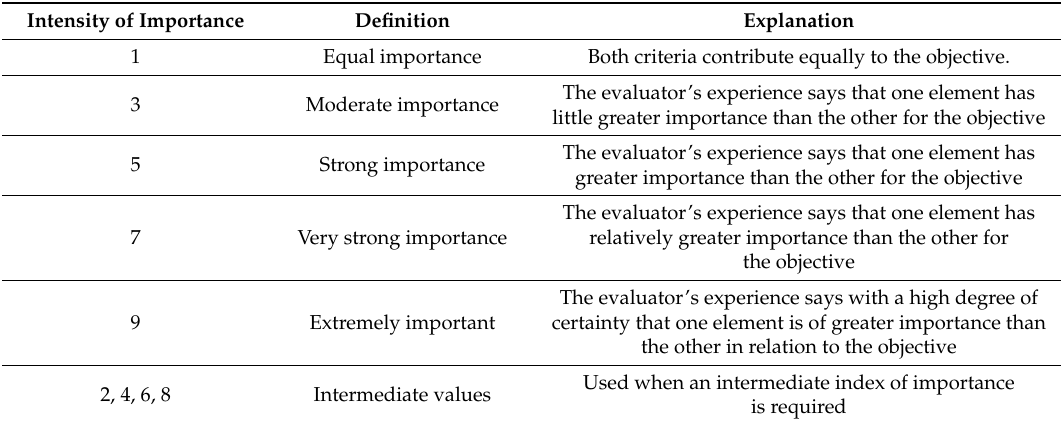
Table 5. Basic Analytic Hierarchy Process (AHP) scale of